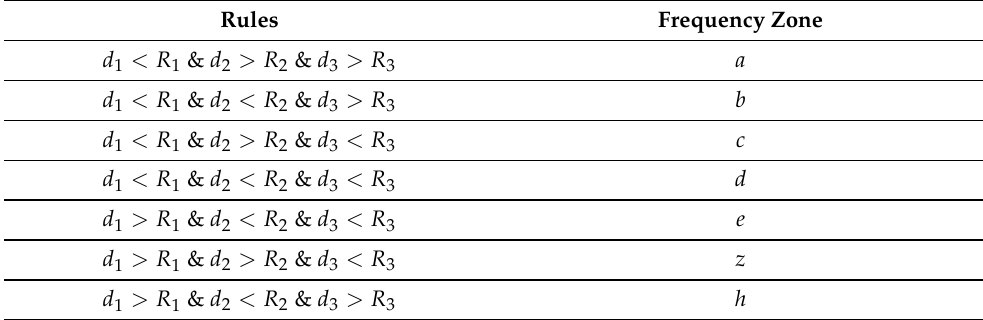
Table 2. Rules to determine the frequency zone of a mobile